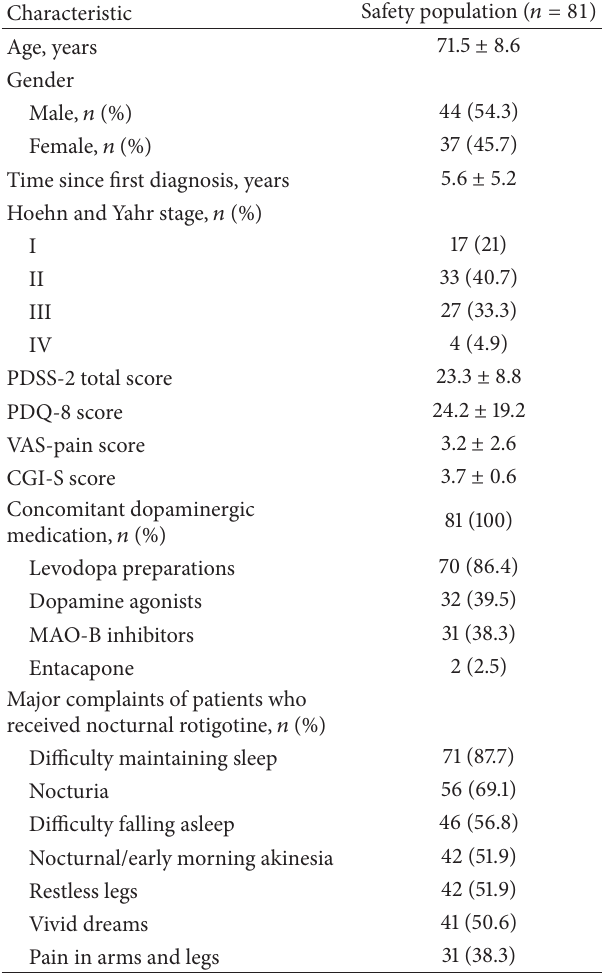
Table 1: Baseline demographic and clinical